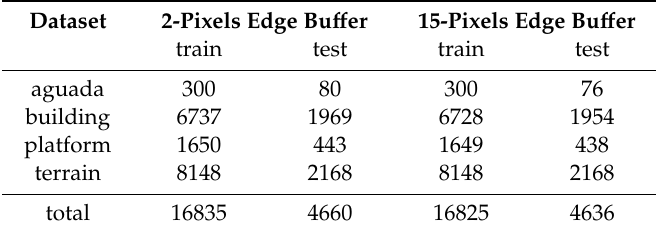
Table 3. Sample count for each class in the training set and the test set for datasets with a 2-pixels and 15-pixels edge bu ff er (around structure polygons). The rotated samples are included in the aguada sample count. The number of samples per class is lower for the dataset with a 15-pixels bu ff er. Samples were omitted from the dataset because the larger bu ff er intersected the border of study area and thus included no-data